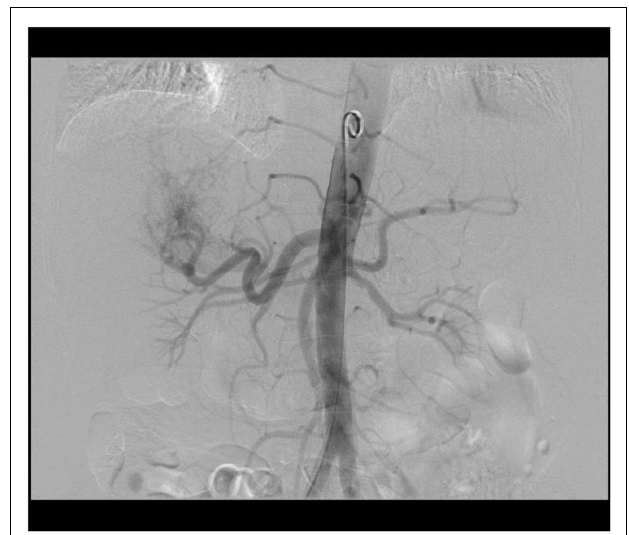
FIGURE 2 |Angiographic image demonstrating hypervascular tumor .